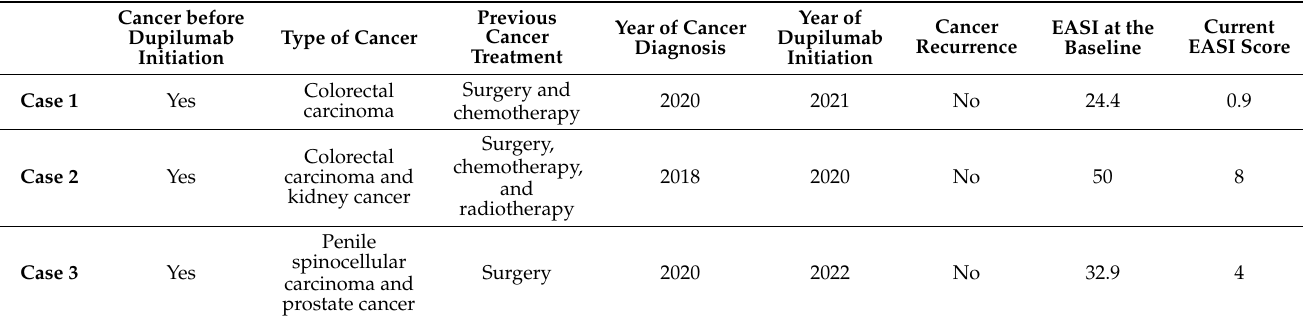
Table 1. Oncologic patients with atopic dermatitis treated with